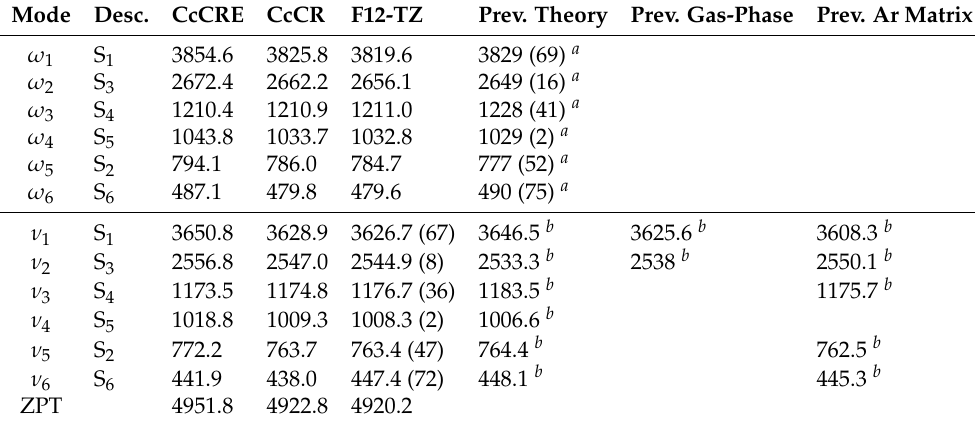
Table 5. Vibrational frequencies (cm − 1 ), and IR intensities (km/mol) given in parentheses for HOSH compared to previous theory and gas-phase